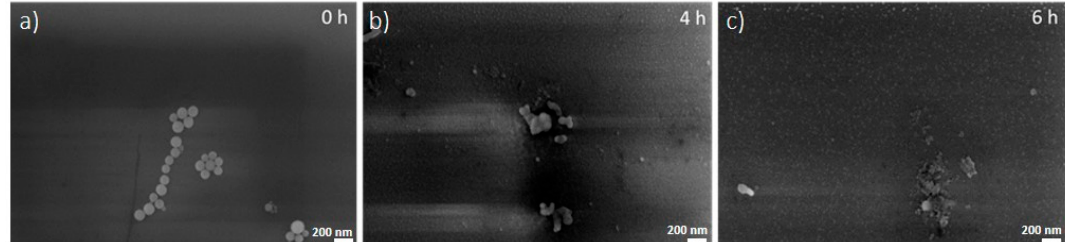
Figure 2. SEM images of dNAs deposited on silicon wafers after ( a ) 0 h, ( b ) 4 h, and ( c ) 6 h of incubation in 20% human serum at 37 °C. Scale bar: 200 nm.